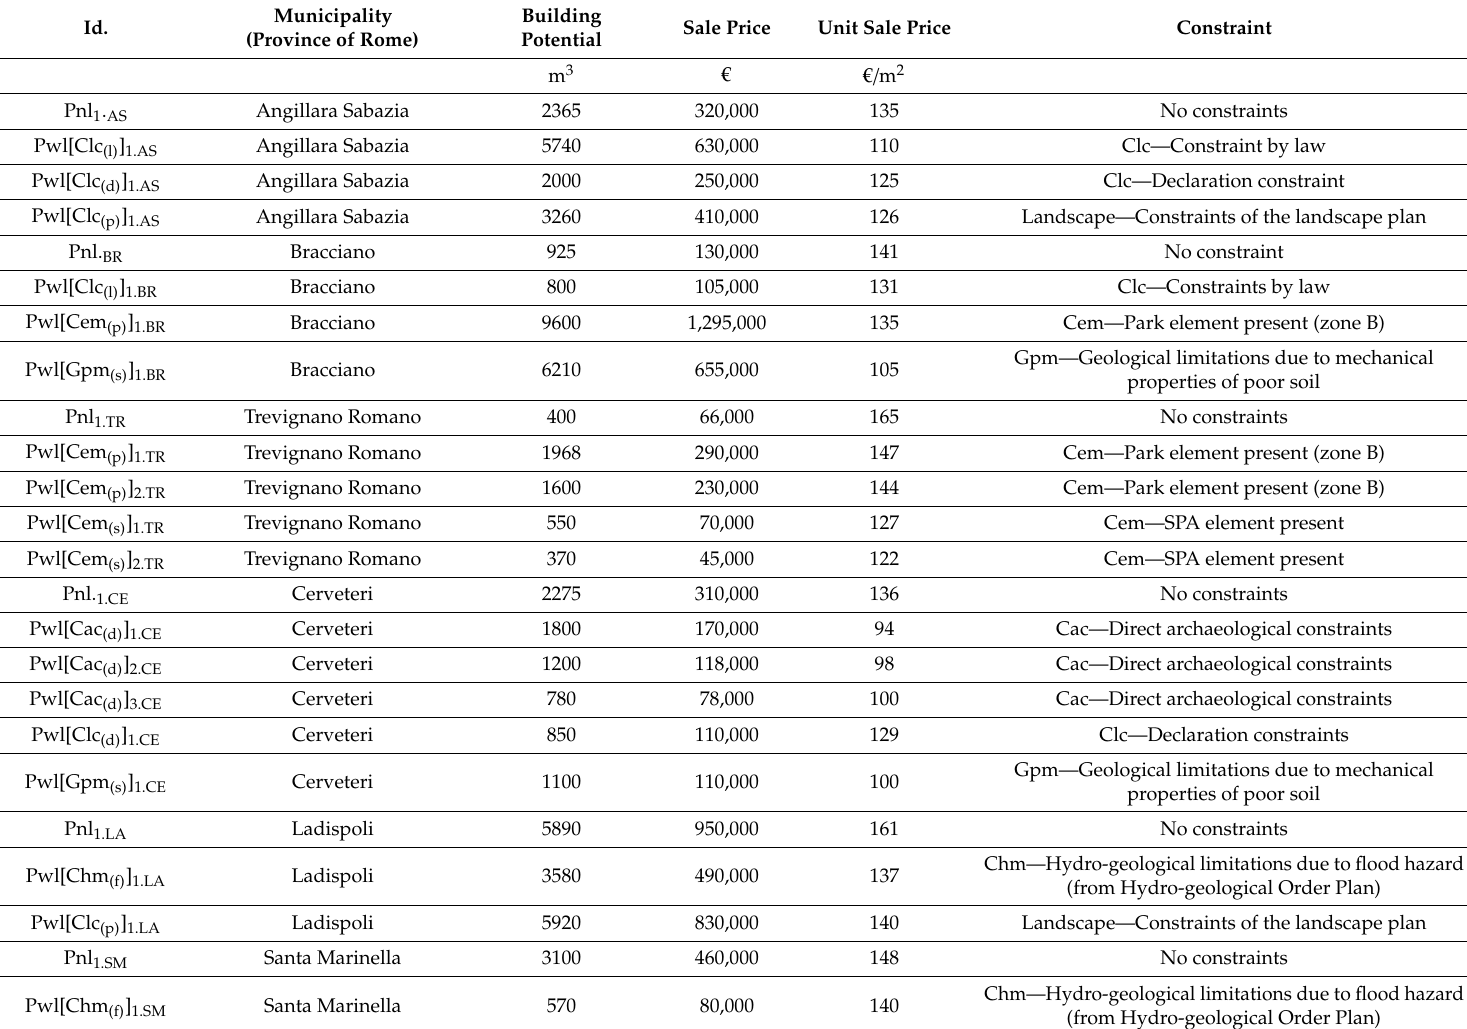
Table 2. Data collection for the application of the